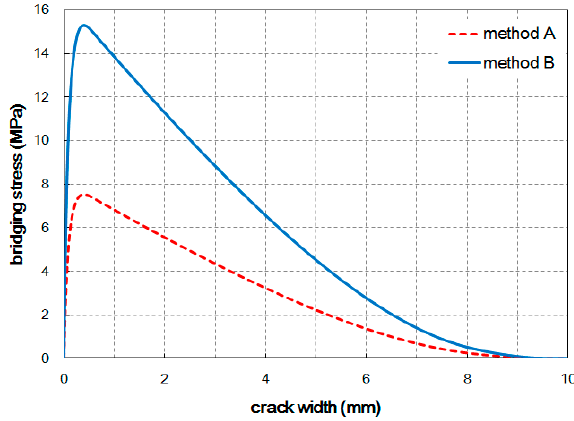
Figure 9. Modified tensile bridging behaviors after considering the number of detected fibers.